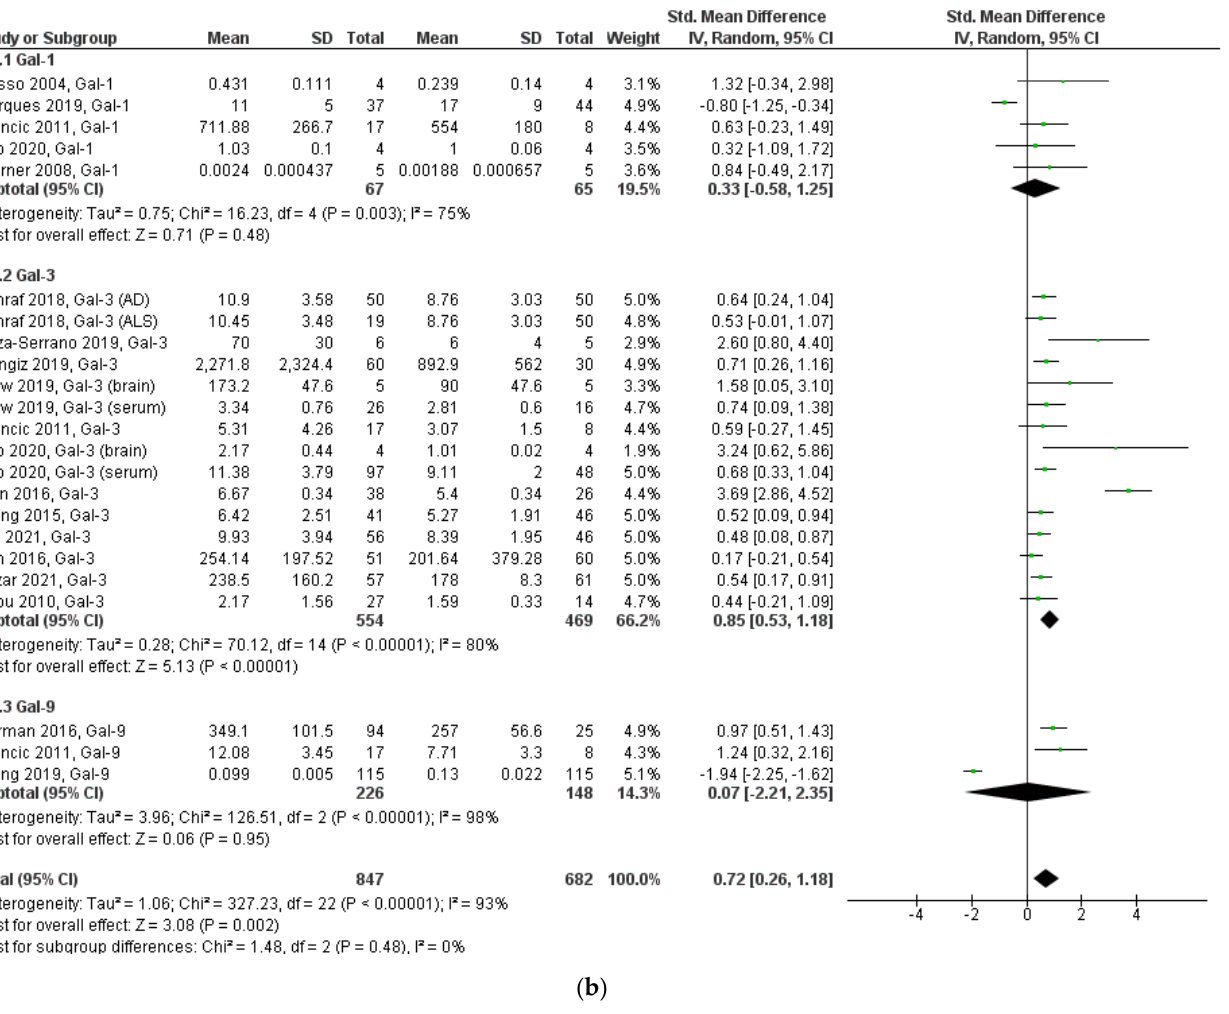
Figure 3. Forest plot of heterogeneity analyses. ( a ) Subgroup analysis by type of neurodegenerative disease, ( b ) subgroup analysis by type of galectin.